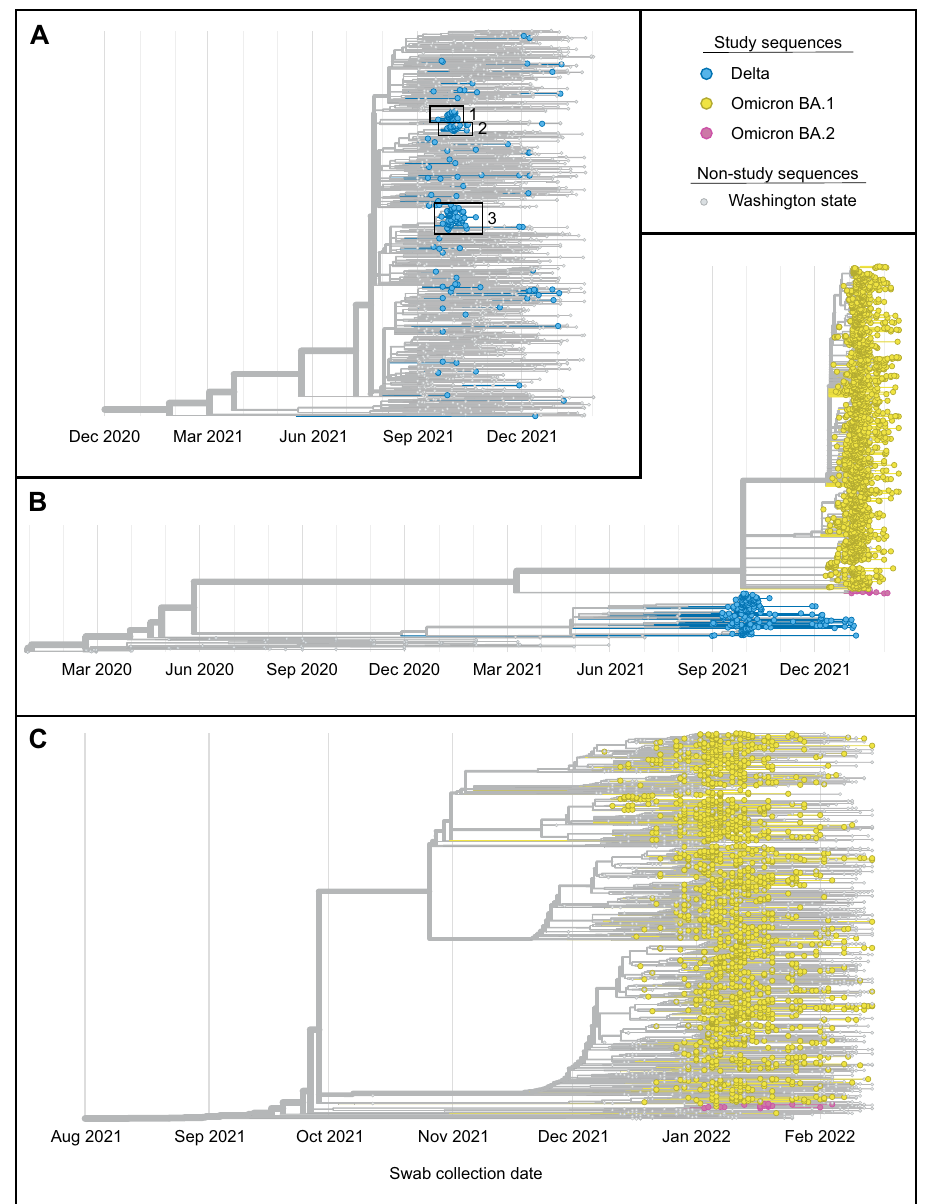
Fig. 3 | Phylogenetics of sequenced campus viral genomes. A Phylogenetic tree of 209 sequenced Delta samples collected on the UW campus and 1174 randomly selected genomes from samples collected in Washington during the same time period. Three monophyletic clusters containing exclusively or almost exclusively study genomes are boxed and numbered. B Phylogenetic tree containing sequen- ces for campus samples collected between September 4, 2021 and February 14, 2022 ( N =1939) plus the Wuhan/Hu-1 reference genome and approximately 100